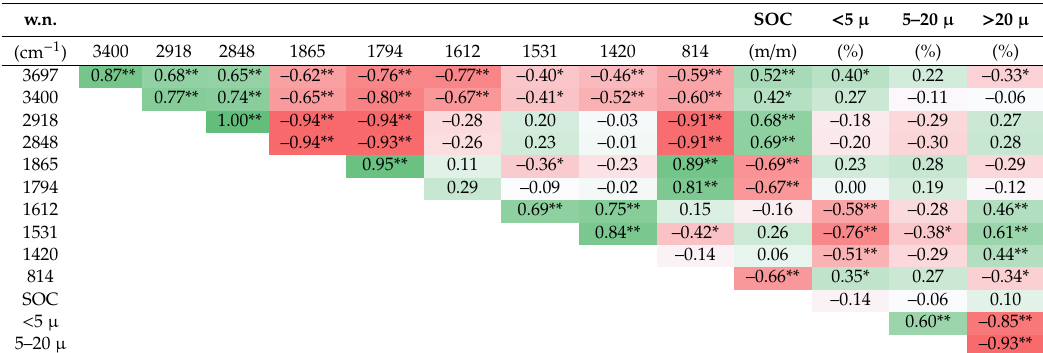
Table 3. Correlation values among the relative absorbances and the investigated wavenumbers, carbon content, and particle size distribution data ( n = 58; w.n.: wavenumber; SOC: soil organic carbon). Green and red colors refer to positive and negative correlations respectively. Saturation indicates the degree of correlation.